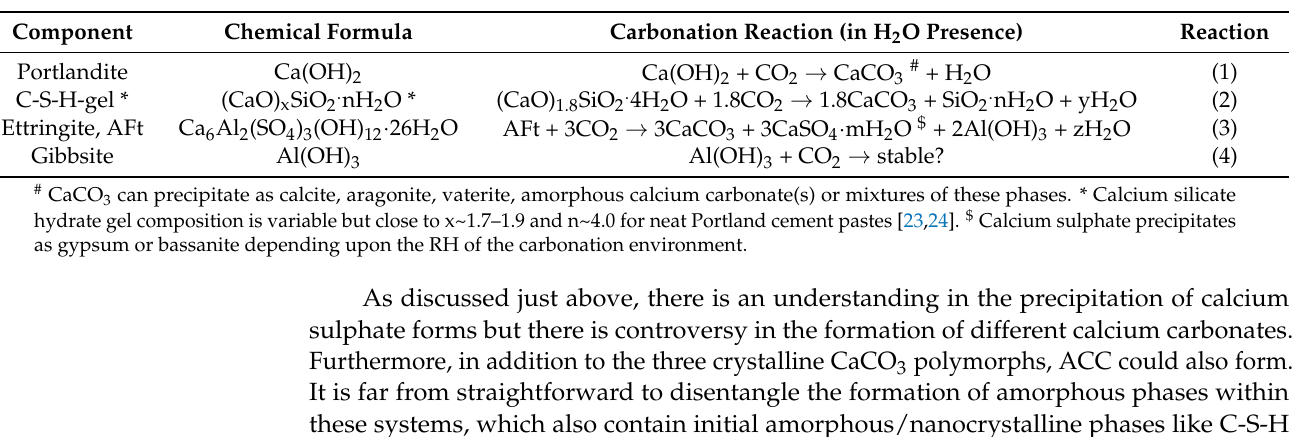
Table 1. Carbonation reactions of selected components in hydrated cement binders